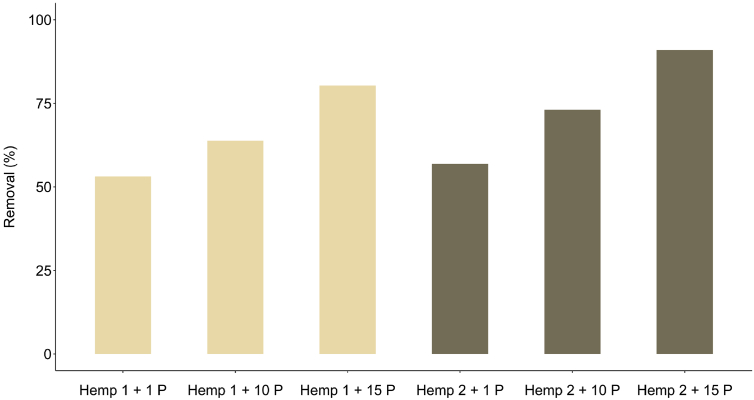
Effect of the number of passes (P) of the fungicide solution in the column on the difenoconazole removal (in %) at two doses of hemp material (conditions: percolation experiments; Hemp 1 = 0.35 g, Hemp 2 = 0.7 g; difenoconazole concentration = 12 mg/L, temperature = 25 °C; n = 3).